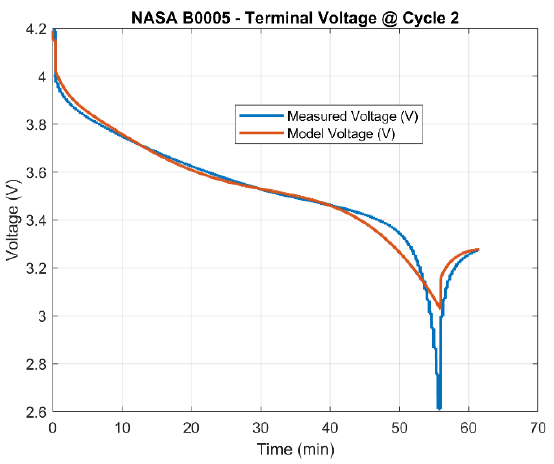
Figure 5. Model vs. Measured Voltage.